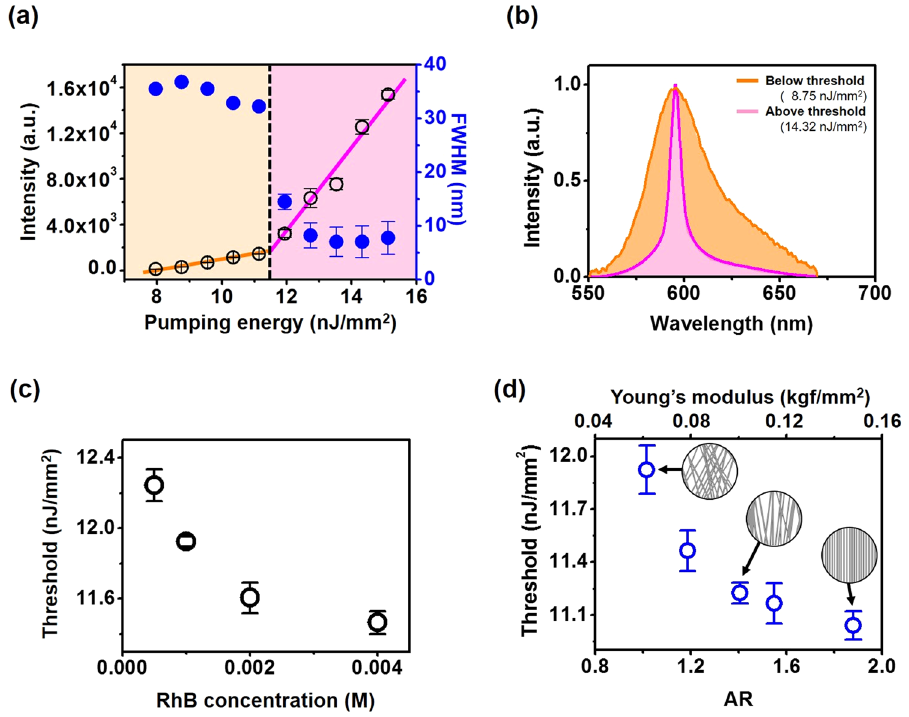
Figure 3. ( a ) Representative intensities (empty black circles), and linewidths (full blue circles) of SF scaffold as a function of pump light energy. Magenta region indicates lasing regime above the threshold (11.46 nJ/mm 2 ). These results are obtained with the scaffolds fabricated at a drum speed of 1,000 rpm (AR = 1.18). ( b ) Normalized lasing emission spectra below (orange solid line) and above (magenta solid line) the threshold. ( c ) Measured lasing thresholds as a function of RhB concentrations. ( d ) Lasing thresholds vs. ARs (bottom) and Young’s moduli (top). The RhB concentration was 0.001